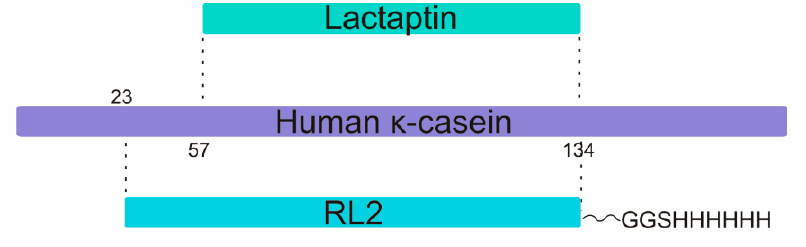
Figure 1. The relation of the primary structures of human κ -casein, its proteolytic fragment lactaptin, and a recombinant analog RL2. Residue Cys8 in RL2 recombinant fragment corresponds to position Cys30 of human kappa-casein polypeptide (P07498 entry).